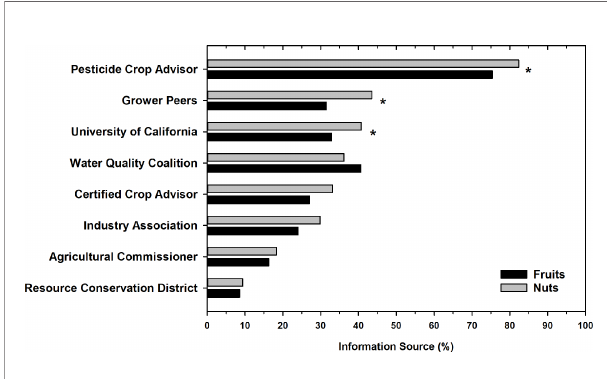
FIGURE 4 | Percentage (%) use of information sources for nitrogen (N) management by fruit and nut growers. Differences at p < 0.05 reported by an asterisk (*) signify the effect is signi fi cant between fruit and nut growers using a Kruskill-Wallis